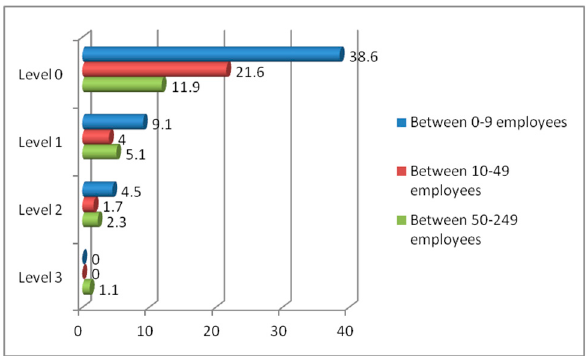
Figure 2. Distribution of answers regarding the level of training of SMEs in the implementation of Industry 4.0 specific technologies.